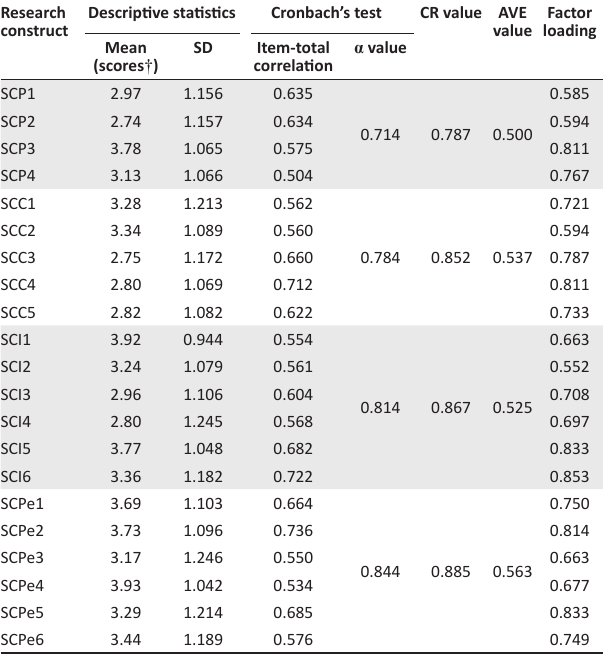
average variance extracted. † , Scores: 1, strongly disagree; 3, moderately agree; 5, strongly